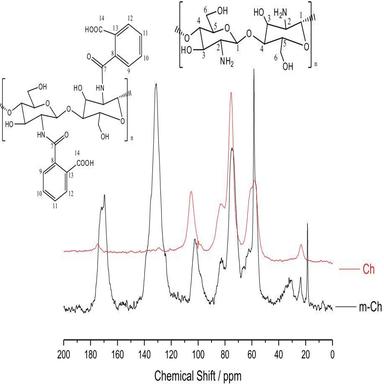
13C Nuclear Magnetic Resonance Spectrum for Ch and m-Ch.